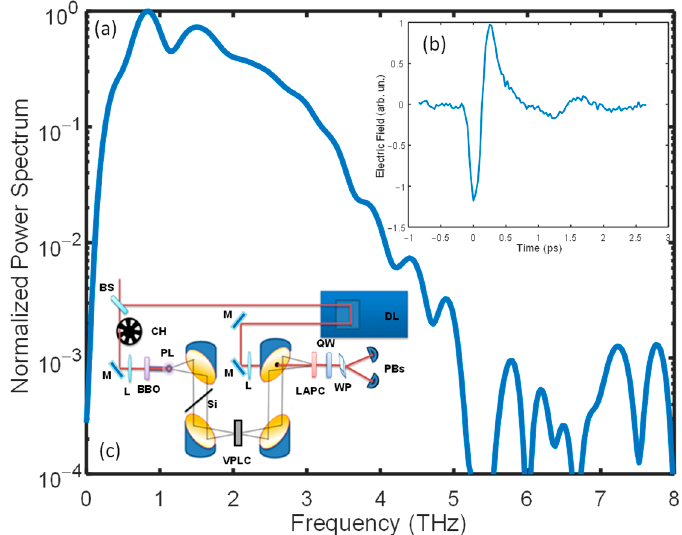
Figure 4. Panel (a) shows an example of the power spectrum of a THz pulse propagating in nitrogen, transmitted through the most absorbing sample, and detected by electro-optic sampling in LAPC (reported in the logarithm scale). Note that the signal is up to 5 THz greater than the background noise. In panel (b) the corresponding THz pulse is displayed. In panel (c) the scheme of our THz spectrometer is shown: BS, beam-splitter; CH, triggered chopper; L, lens; BBO, SHG crystal; PL, plasma; Si, silicon wafer; M, mirror; DL, delay line; VPLC, variable-path liquid cell; LAPC, electro- optic crystal; QW, quarter-waveplate; WP, Wollaston prism; BPs, balanced photodiodes.